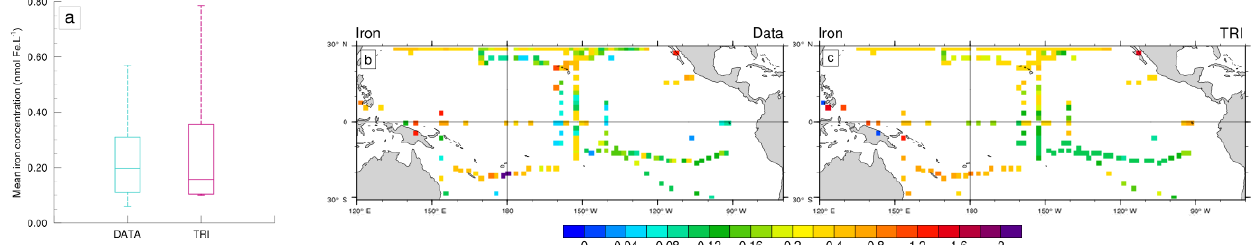
Figure 2. (a) Box plots of the 0–150m averaged Iron (nmolFeL − 1 ) data (blue) and the equivalent for the model (red) co-localized with the observations in space and time. The coloured box represents the 25–75% quartile of the distribution, the whiskers the 10–90% percentile distribution. The line inside the coloured box is the median. (b, c) Iron concentrations (nmolFeL − 1 ) as observed (b) and as simulated by the model (c) . Iron concentrations have been averaged over the top 150m of the ocean. Model values have been sampled at the same location, the same month, and the same depth as the